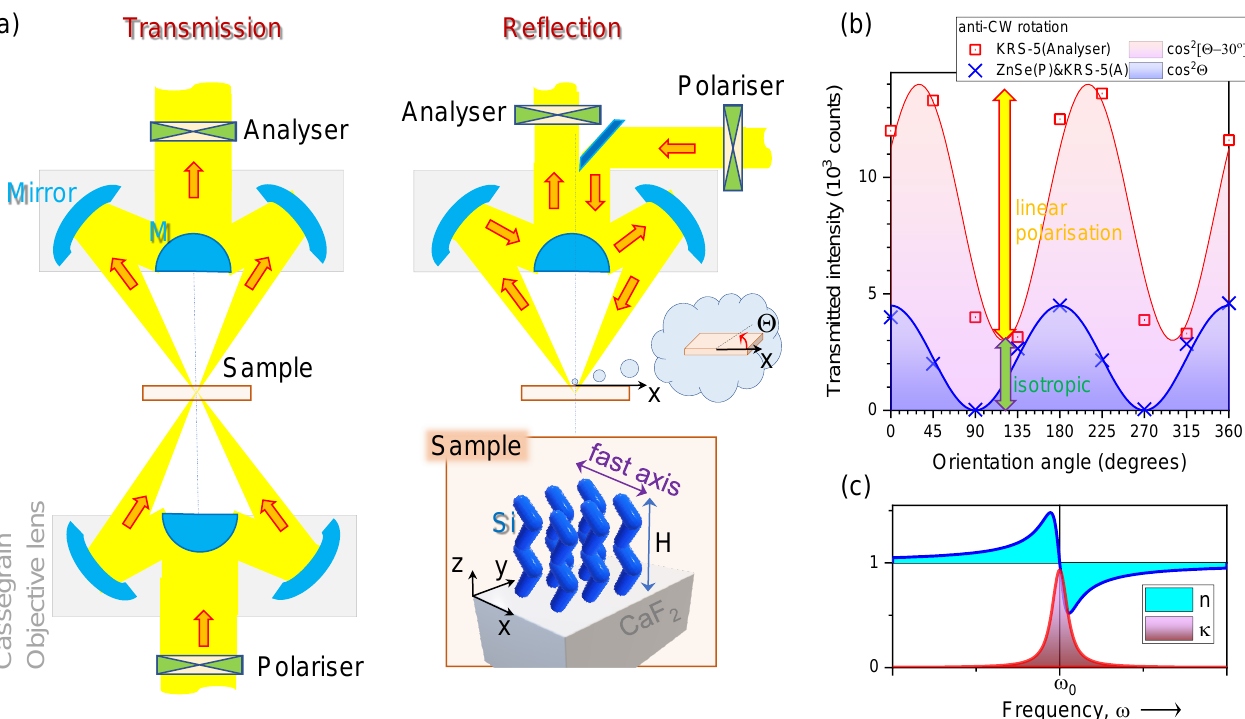
Figure 1. ( a ) Transmission and reflection modes with the possibility to set polarisation of the incident IR beam and analysis at the transmitted (or reflected) light; θ is sample’s orientation angle with θ = 0 ◦ corresponding to the x -axis. Samples were Si and SiO 2 columnar structures of H ≈ 1 µ m height deposited by GLAD at φ ∼ 70 ◦ on a substrate (silica, CaF 2 , Si). The sketch shows Si columnar structures deposited via zig-zag folding (6 s deposition switch) along the x -axis during GLAD on IR transparent CaF 2 ; folding direction defines the optical fast-axis with refractive index n e < n o due to structural anisotropy; ( b ) transmitted power through one (red) and two (blue) crossed polarisers used in experiments. A crossed polariser (P)—analyser (A) eliminated transmitted power; measurements were carried out in transmisssion mode with a 5.6 µ m aperture pinhole, which was contributing to a better axial resolution; ( c ) Lorenzian lineshapes for absorption A ( ω )